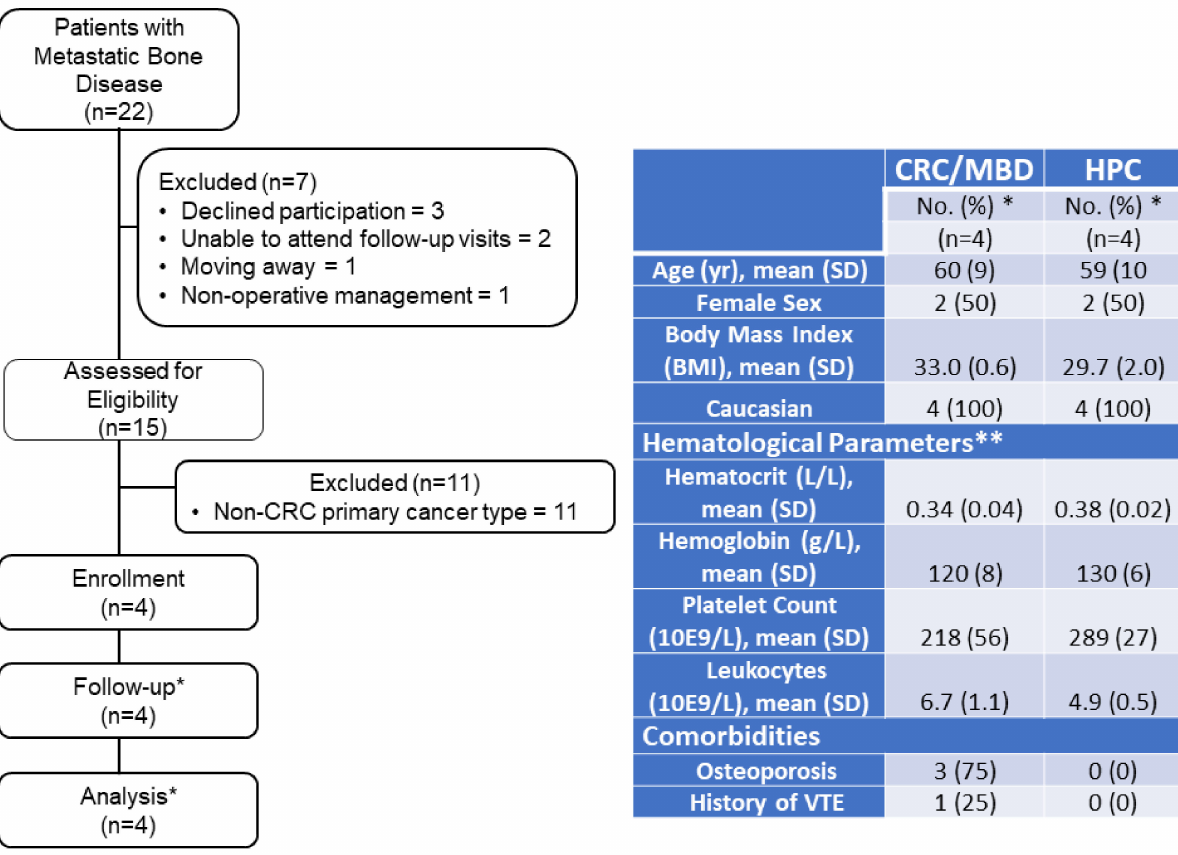
Figure 1. Flowchart of study recruitment and Participant Demographics and Anthropometric Data. * Unless noted otherwise; ** pre-operative values in CRC/MBD